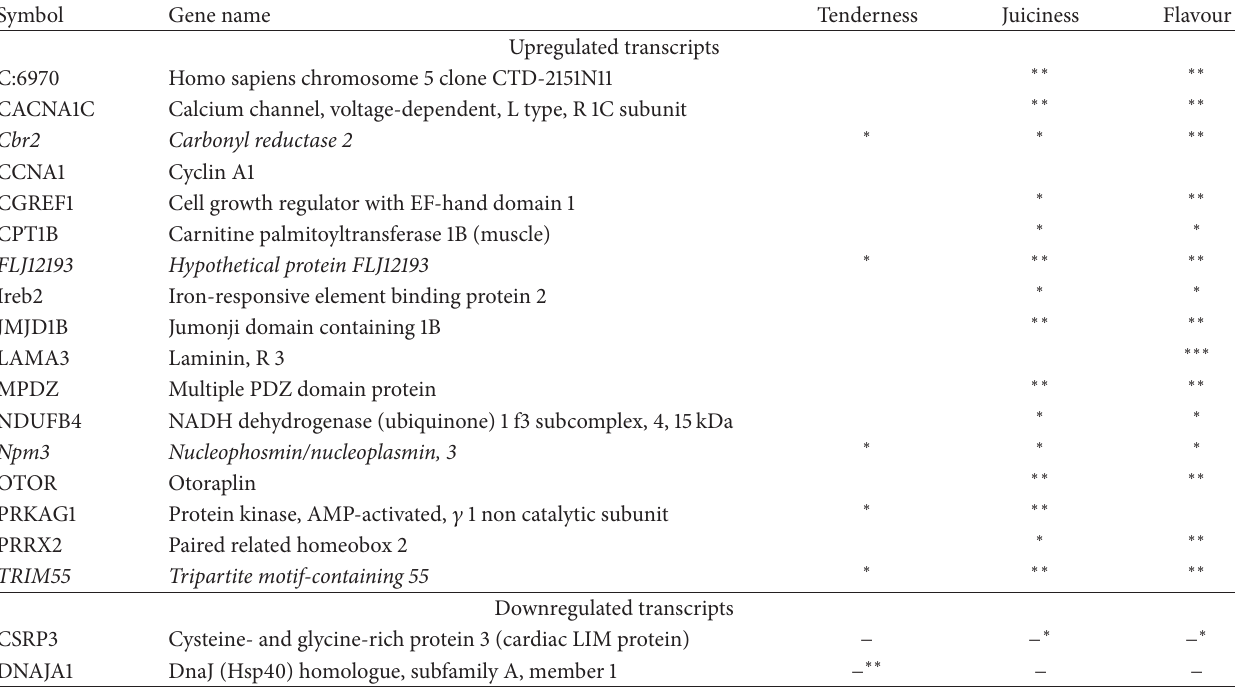
Table 2: Expression markers of tenderness, juiciness, and flavour in the longissimus thoracis of young Charolais bulls (adapted from [9]).